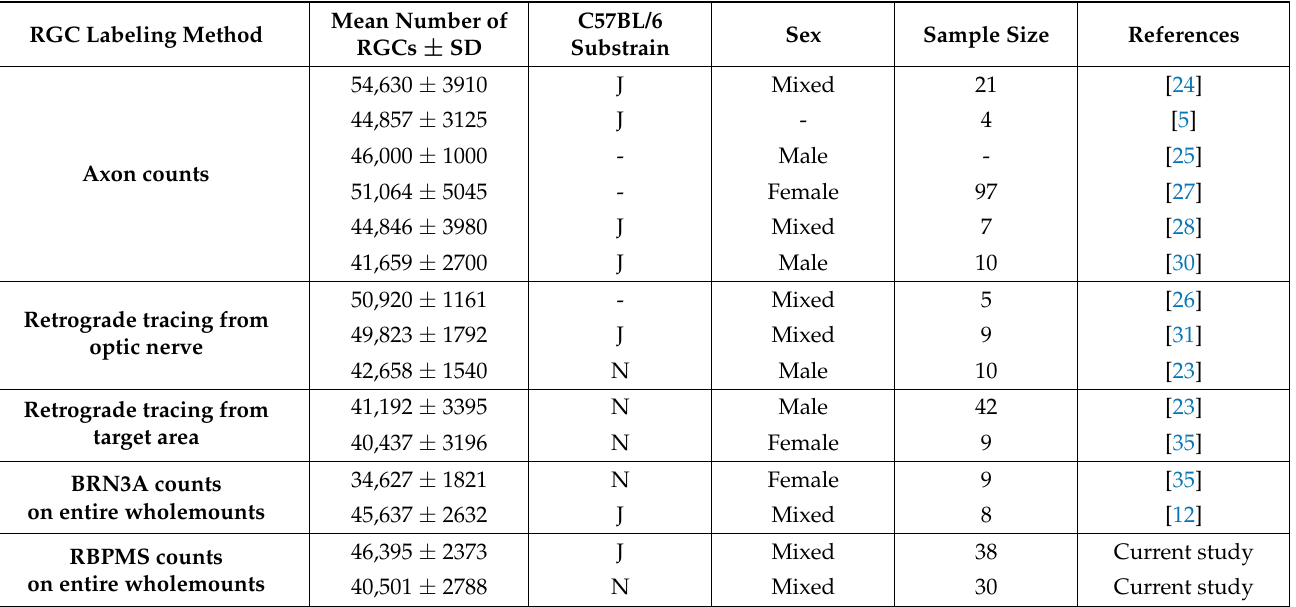
Table 3. Global RGC counts in C57BL/6 mice assessed via axonal counts, retrograde tracing or BRN3A immunolabeling. Key: - = not